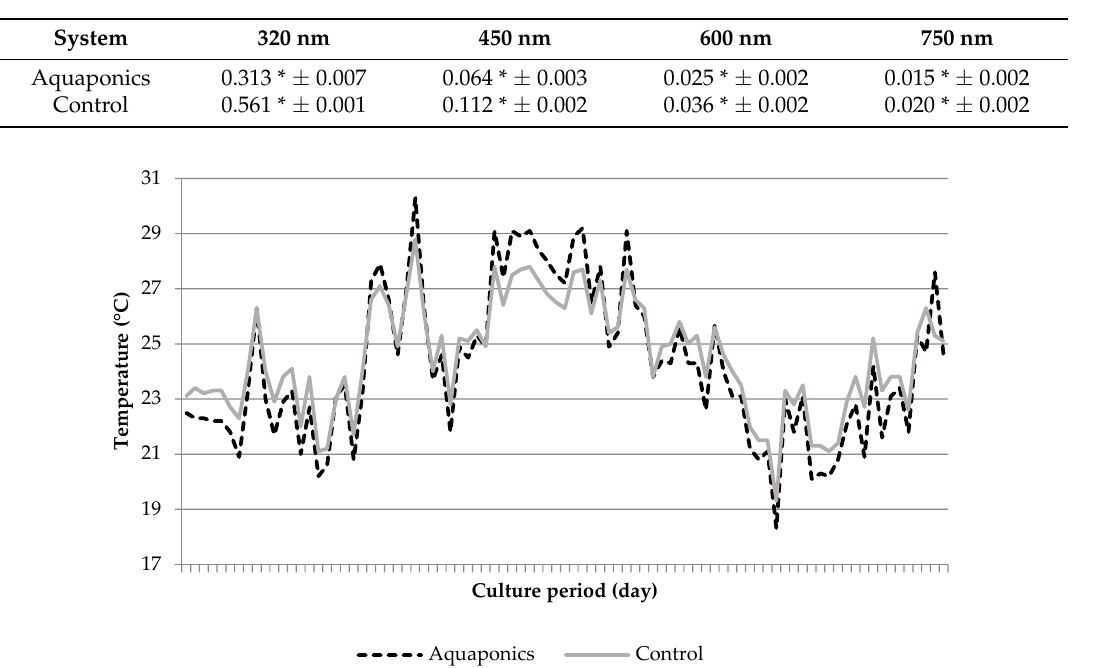
Table 2. Mean values ± SEM of water turbidity extinctions for both systems at different wavelengths; * statistical significance ( p < 0.05).